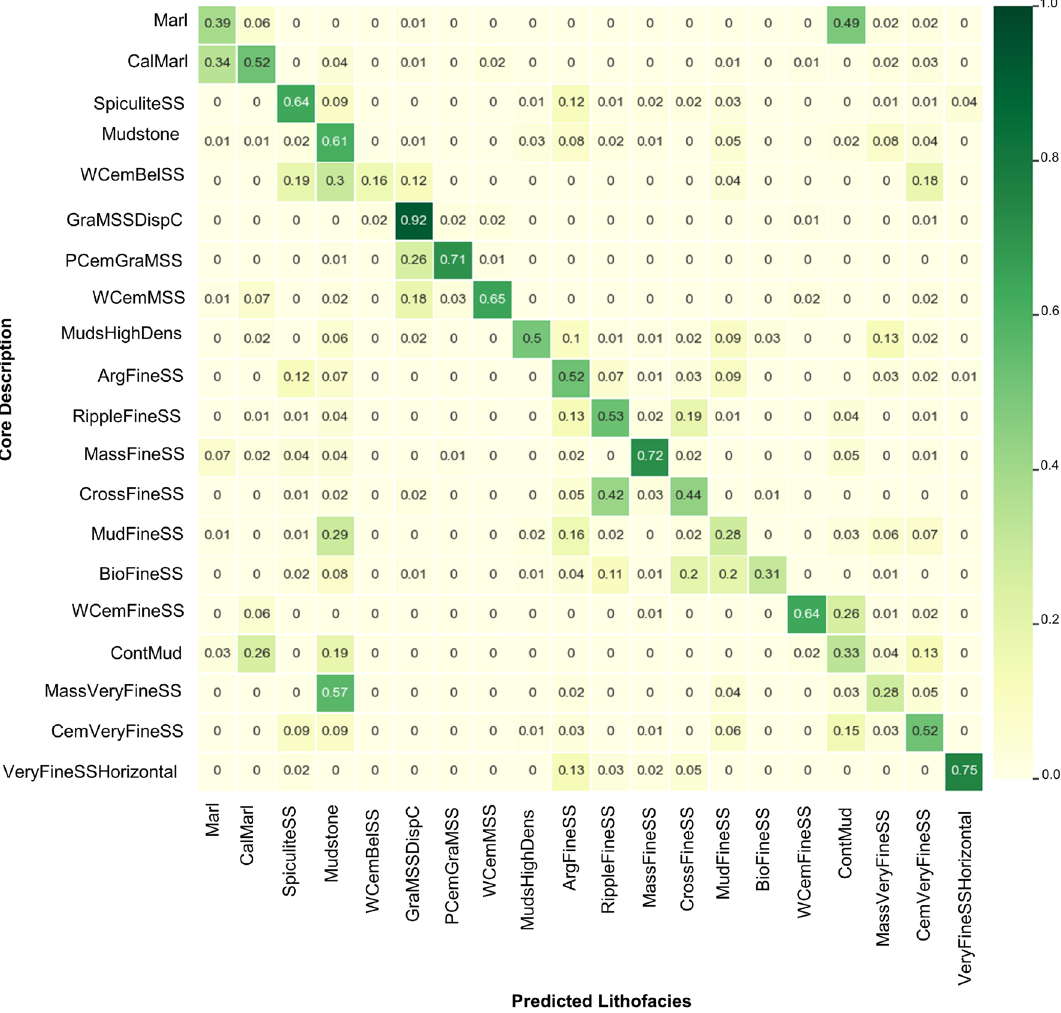
Fig. 9 Confusion matrix for the test set